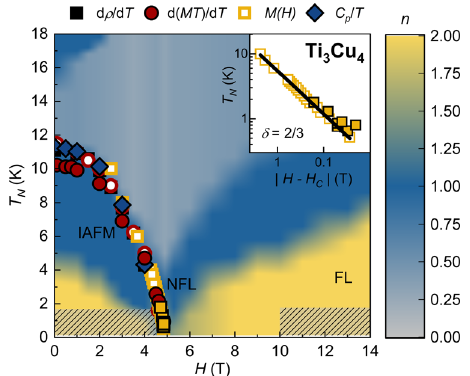
Fig. 6 Temperature – magnetic fi eld phase diagram for Ti 3 Cu 4 . The Néel temperature T N , below which Ti 3 Cu 4 is an itinerant antiferromagnet (IAFM), were determined from the temperature dependent derivative of magnetization multiplied by temperature d ( MT )/d T (red circles), isothermal magnetization M ( H ) (yellow squares), heat capacity scaled by temperature C p / T (blue diamonds), and temperature dependent derivative of the resistivity d ρ /d T (black squares). Examples of the data used to construct the phase diagram are shown in Supplementary Fig. 3. Closed and open symbols denote measurements with H ∥ c and H ∥ ab , respectively. The IAFM order is fully suppressed for applied magnetic fi elds above H C = 4.87 T, Fig. 5 Electronic structure from density functional theory calculation. a, b and the contour plot maps the resistivity ( ρ ) exponent n from fi ts of and c Fermi sheets constituting the Fermi surface (FS) of Ti 3 Cu 4 . Panel ( a ) ρ = ρ + A n , exhibiting a crossover from non-Fermi liquid behavior (NFL) 0 n T displays the FS originating from the d orbital of Ti2, which contributes ( n <2) to a Fermi liquid (FL) region n = 2 as the quantum critical point (QCP) x 2 (cid:2) y 2 most to the density of states (DOS) at the Fermi level. The arrows indicate is crossed in the fi eld direction at the lowest measured temperatures. The grey possible nesting wavevectors of the FS. d Band structure near the Fermi hashed regions correspond to temperatures not accessed by our ρ ( T ) level of Ti 3 Cu 4 . The width of the red line is proportional to the projection experiments. (inset) A log-log plot of T N vs. ∣ H − H C ∣ (yellow squares), with the onto the d x 2 (cid:2) y 2 orbital of Ti2. e , f Projected density of states (PDOS) in the black line corresponding to the fi t of T N ∝∣ H − H C ∣ δ , yielding paramagnetic (PM) and spin-density wave (SDW) phase, respectively, with H C = 4.87±0.005 T and δ = the red line indicating the contribution of Ti2 d x 2 (cid:2) y 2 orbital. The blue lines indicate the partial density of states of the other Ti2 d -orbitals, which are comparatively negligible at the Fermi level.